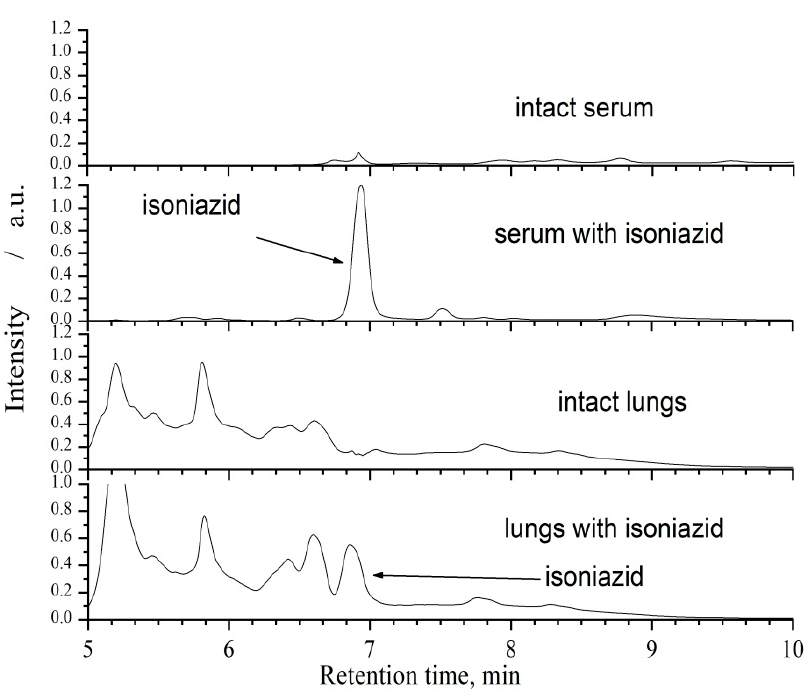
Figure 1. Examples of chromatograms of intact blood serum, blood serum with isoniazid added, intact lungs and lungs with isoniazid added.